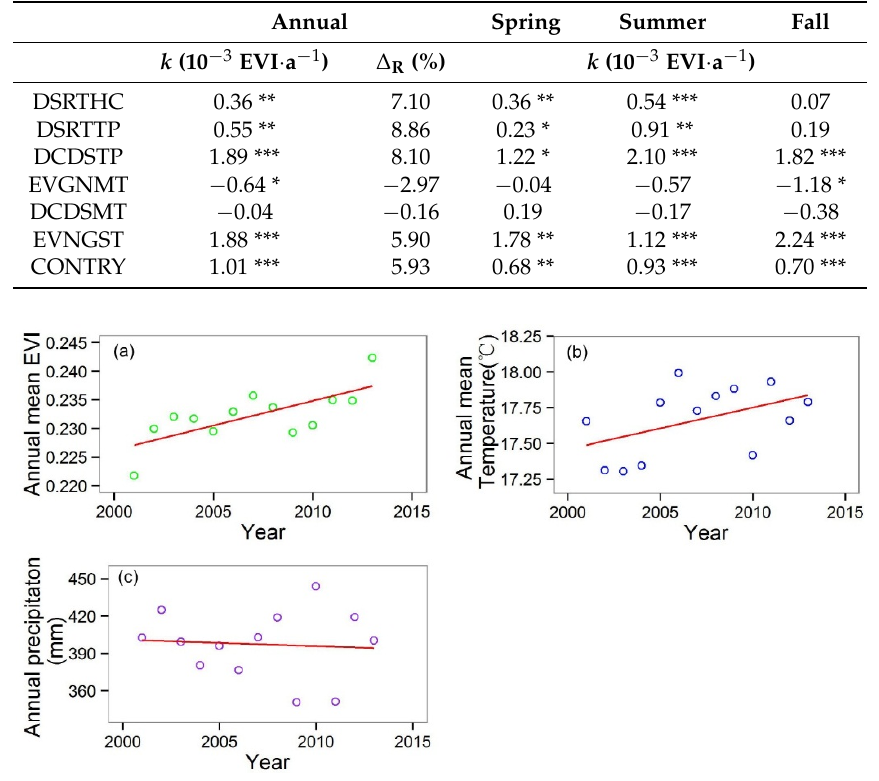
Figure 2. Annual mean EVI ( a ); temperature ( b ); and annual precipitation ( c ) of the China shrublands. Solid lines represent the regression with Generalized Least Squares method to derive trend from the time series .